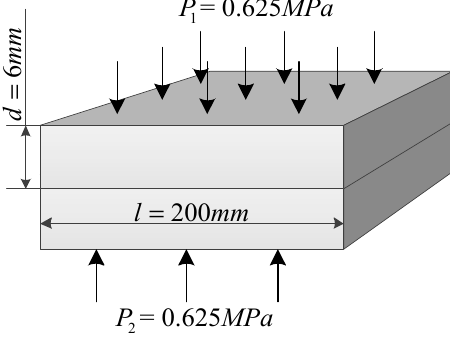
Figure 1. Dimensions of the specimen.